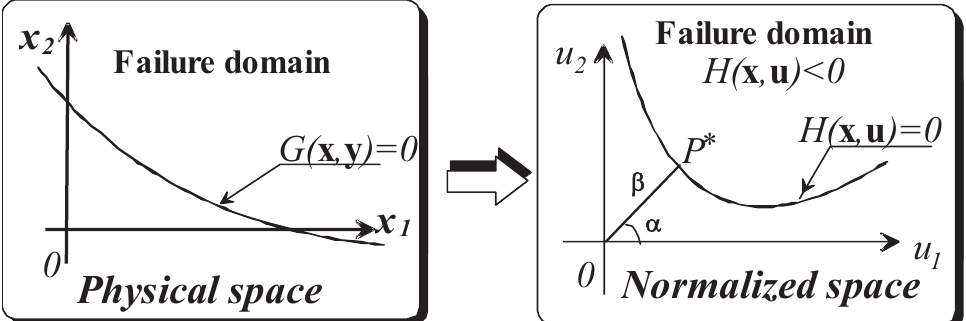
Fig. 1. The transformation between the physical space and normalized